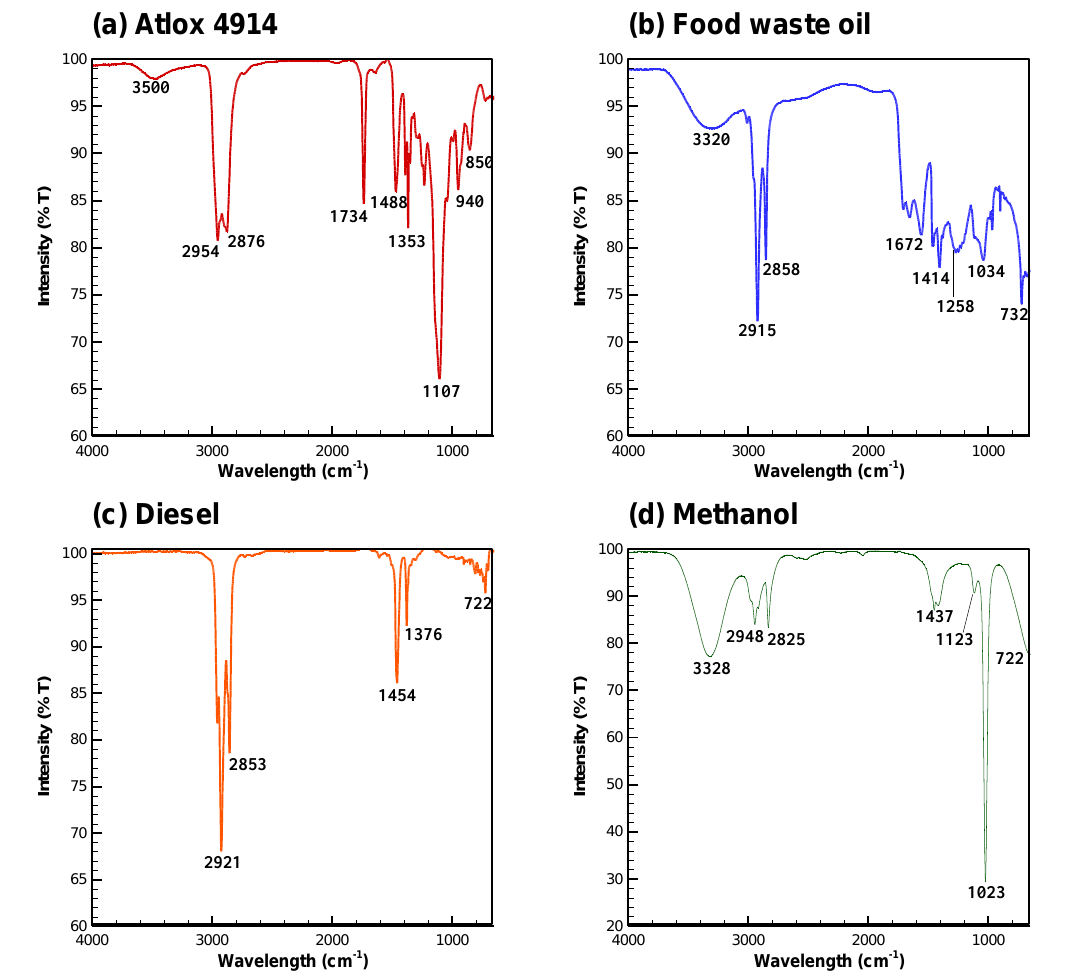
Figure 2. FTIR spectra of ( a ) Atlox, ( b ) bio-oil, ( c ) diesel, and ( d ) methanol.